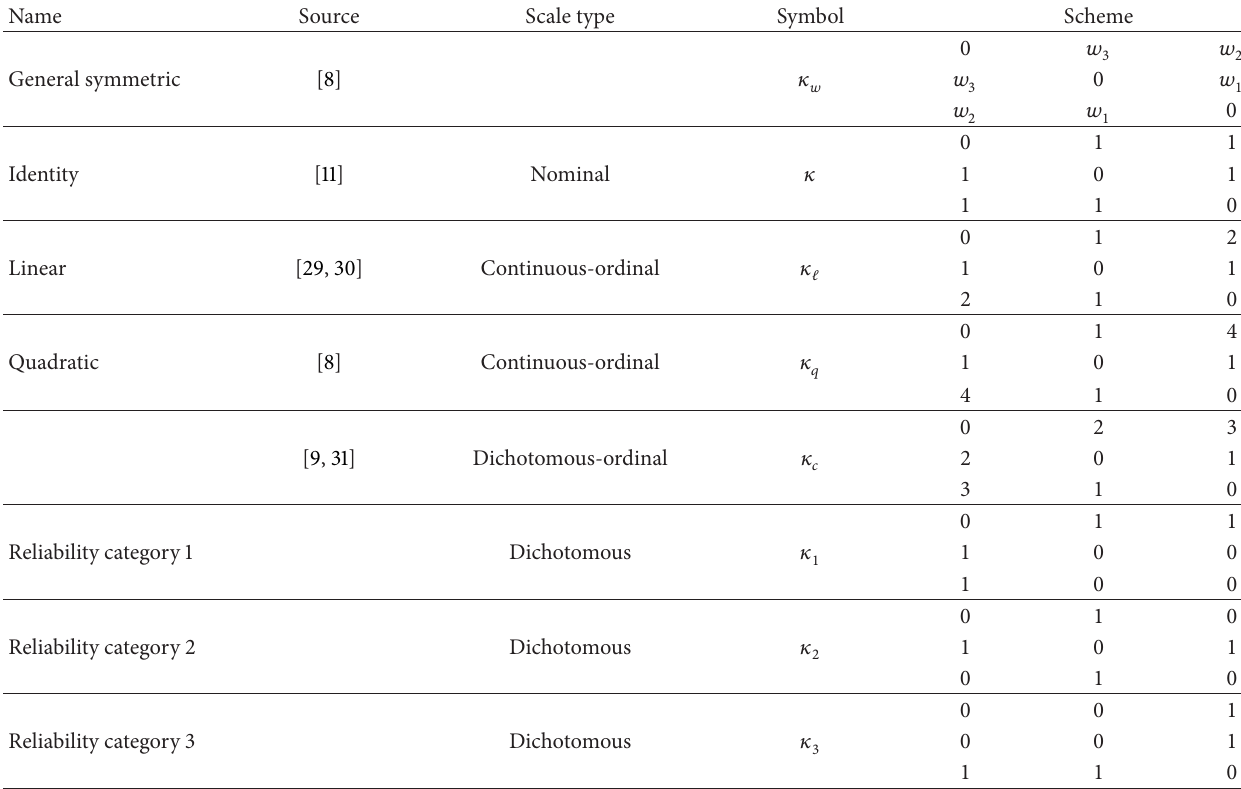
Table 3: Eight weighting schemes for 3 × 3